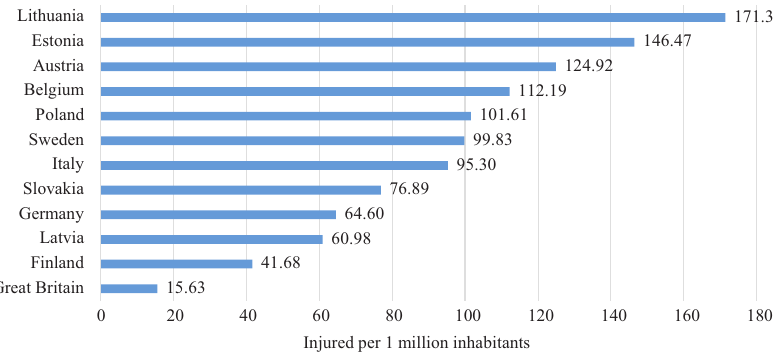
Figure 4. Road traffic injury rate (number of people injured per 1 million inhabitants) at PCs